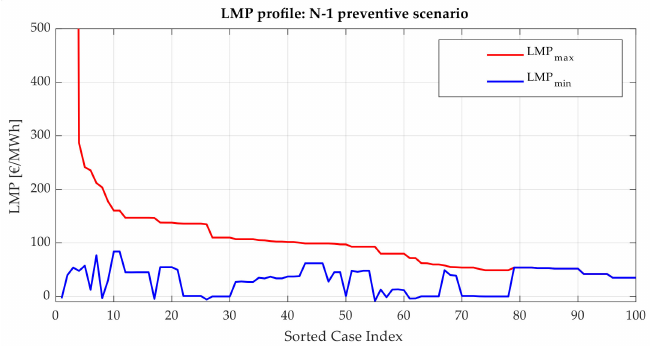
Figure 15. LMP profile over considered case: N1prev